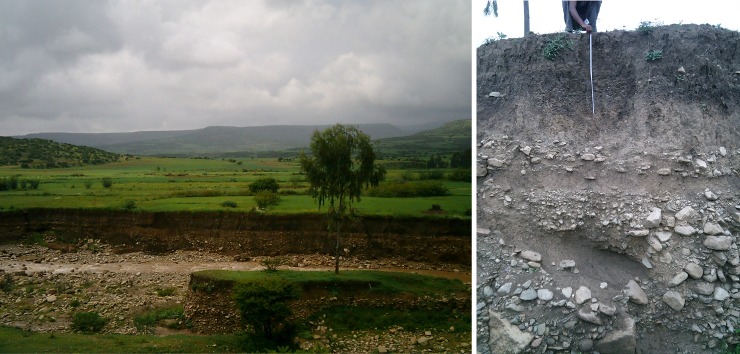
Location of soil profile O along the Agula’e river (left) and profile O (Mollic Calcaric Fluvisol, right).